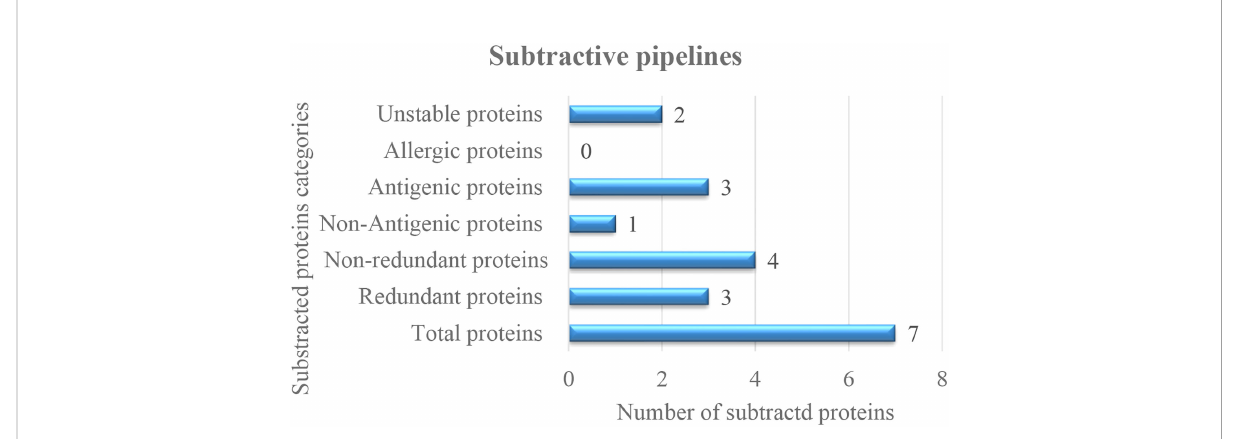
FIGURE 2 Shortlisted proteins for good vaccine candidate 3.2 Mapping of